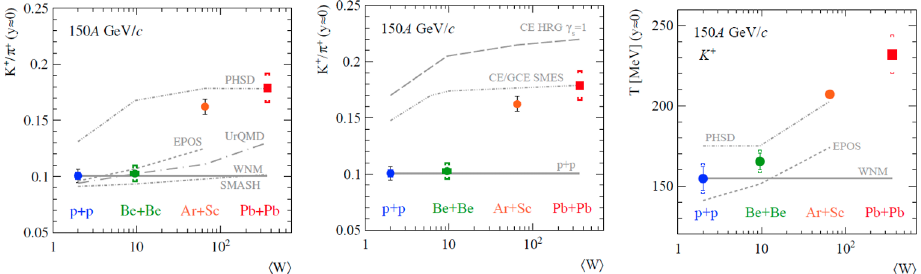
Figure 4. The system size dependence of ⟨ K + ⟩ / ⟨ π + ⟩ ratio at mid-rapidity compared to dynamical ( left ) and statistical ( middle ) models; the system size dependence of inverse slope parameter T of K + m T spectra compared to dynamical models ( right